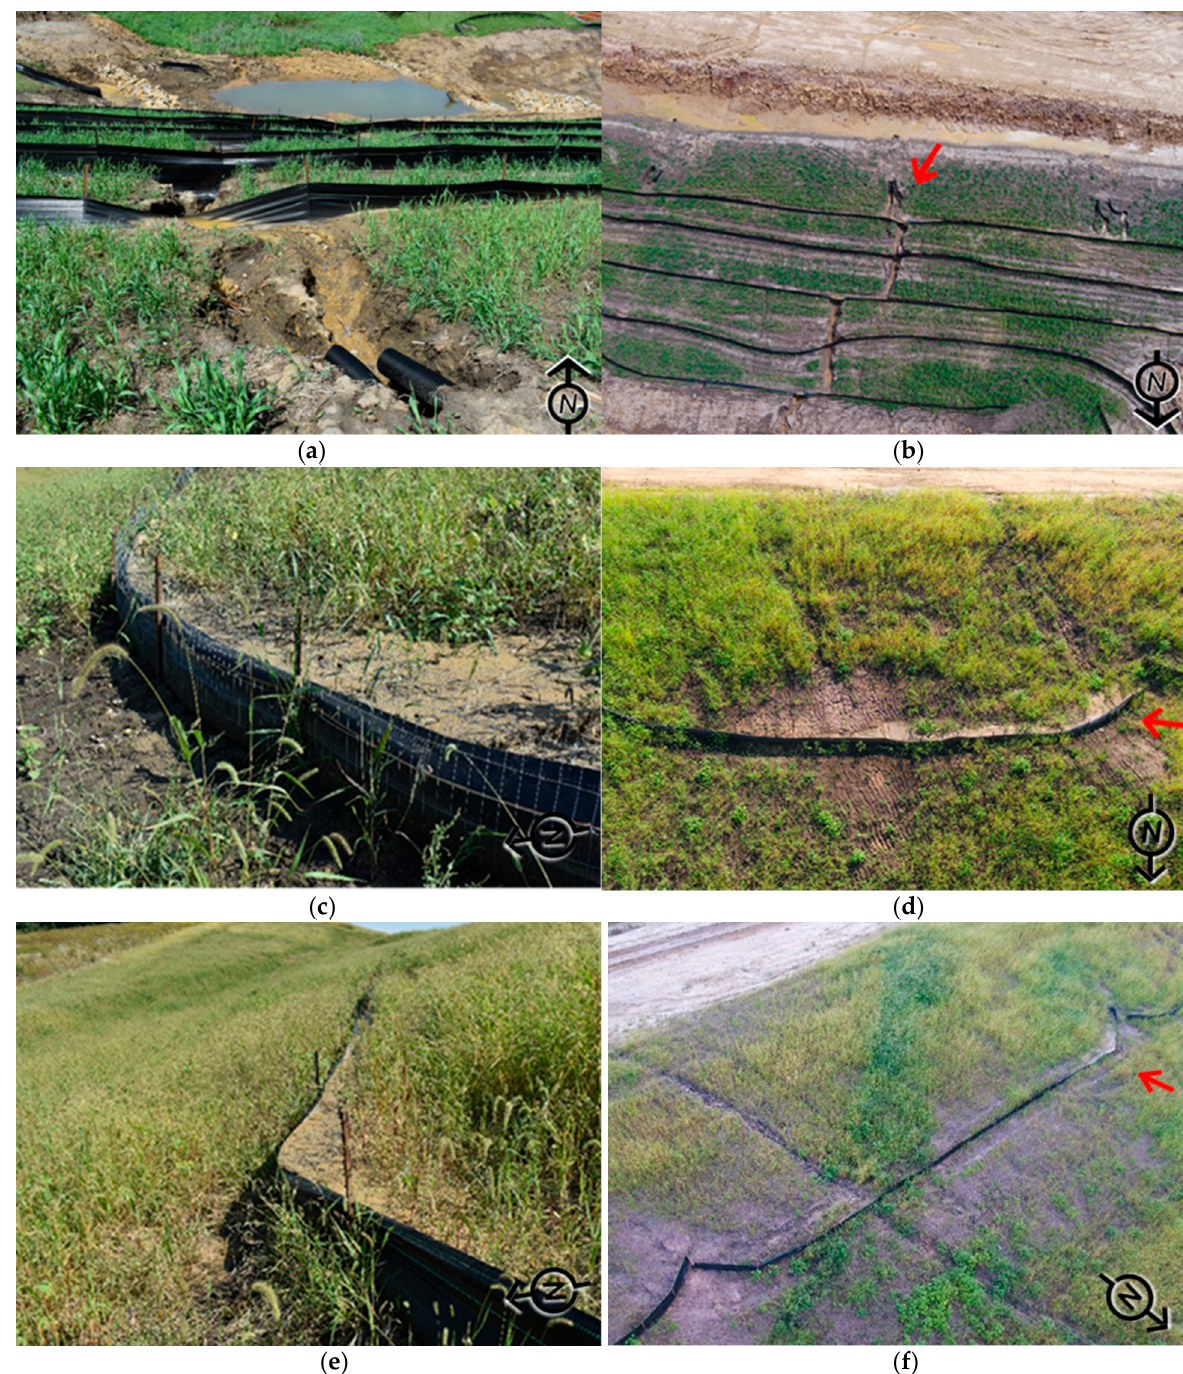
Figure 6. Comparison of silt fence inspection documentation: ( a ) overtopping failure (ground perspective); ( b ) overtopping failure (aerial perspective); ( c ) sediment accumulation (ground perspective); ( d ) sediment accumulation (aerial perspective); ( e ) sediment accumulation (ground perspective); ( f ) sediment accumulation (aerial perspective) Table 1. Mean average precision (MAP) values for detected